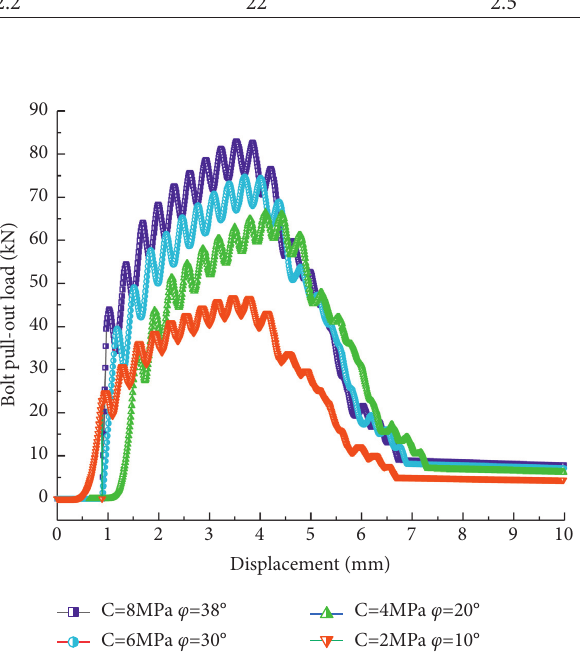
Figure 10: Pull-out load and displacement curves of bolts under different cohesion and interior friction